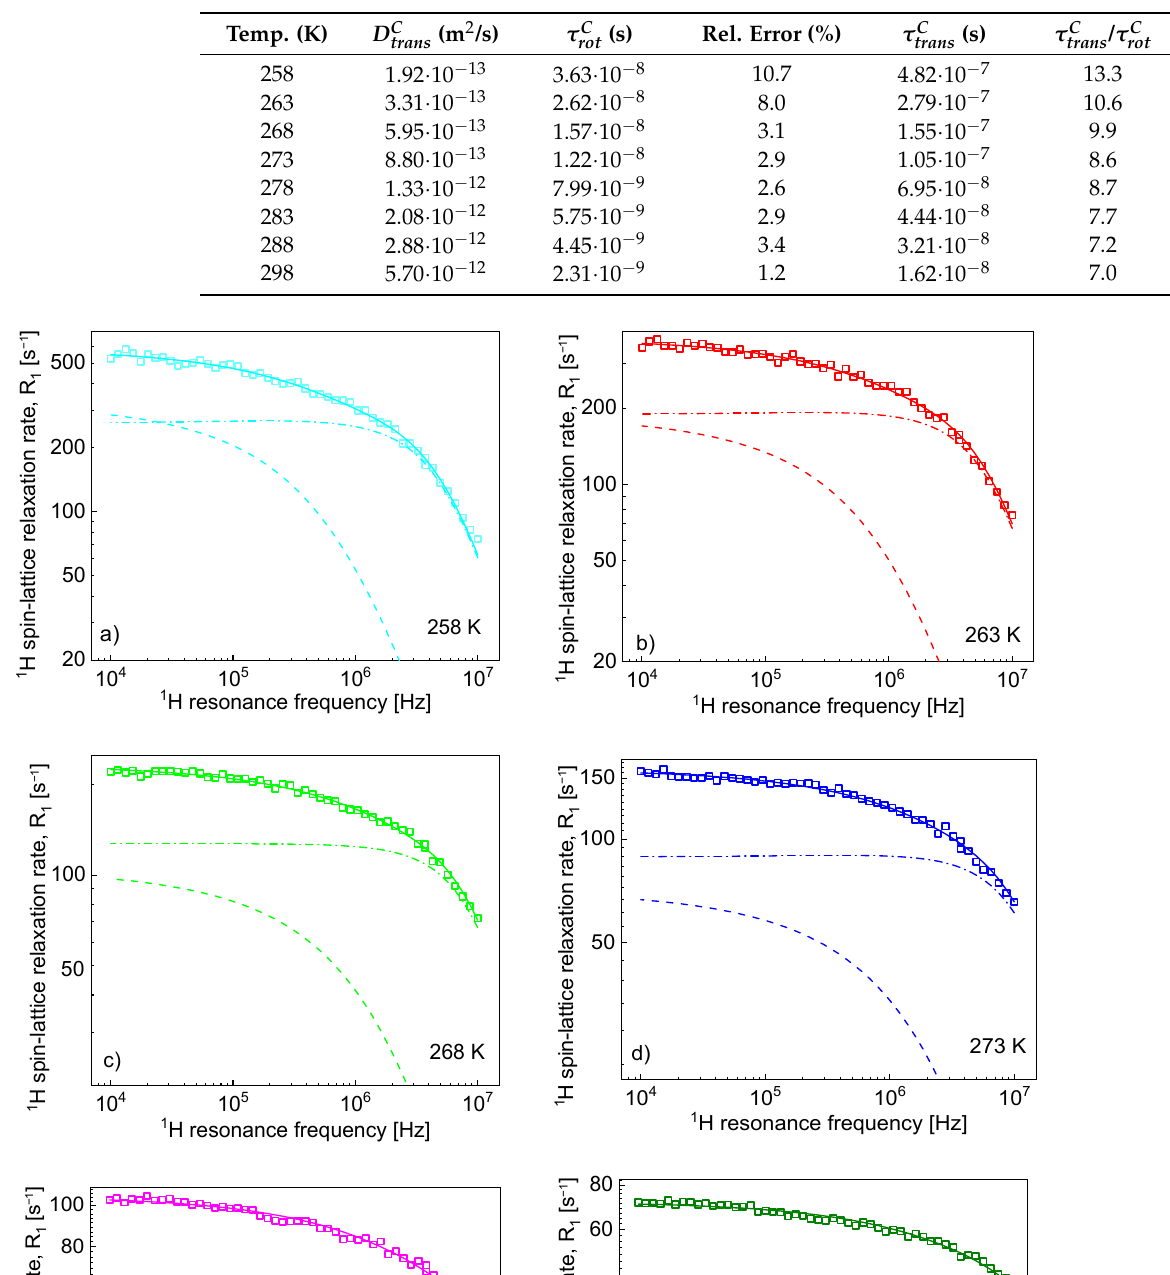
Table 1. Parameters characterising the translational and rotational dynamics of the TEA-C4 cation in [TEA-C4][TFSI]; C HH = 1.49 · 10 9 Hz 2 , d CC = 4.30 Å. The correlation time τ C DD = d 2 CC . from the relationship: τ C trans 2 D C trans